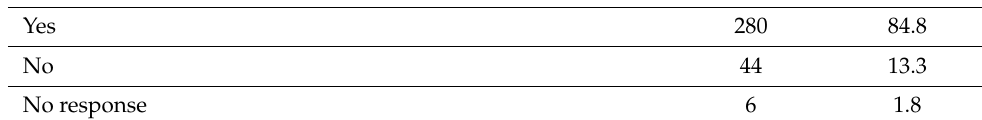
Table 5. Respondents’ experiences and opinions concerning oral sex discussion in clinical, academic,